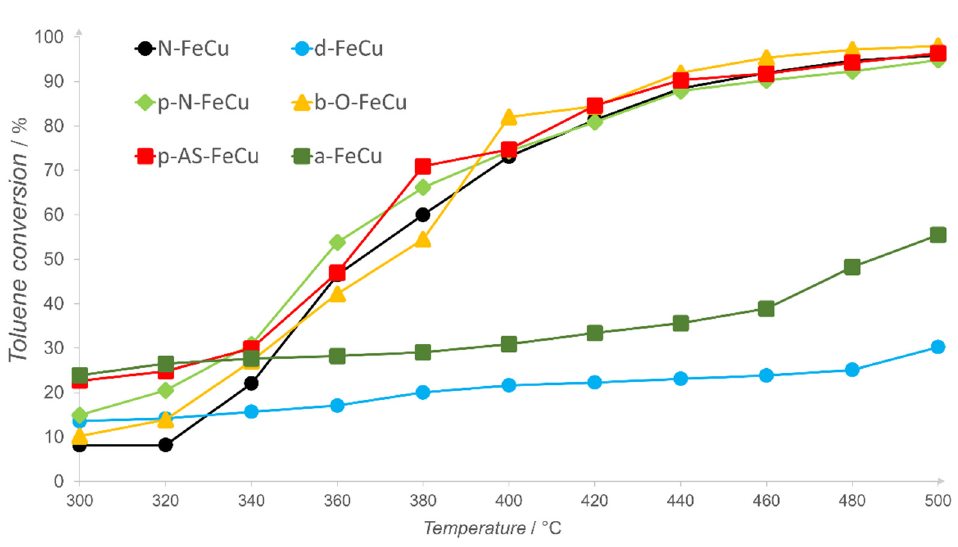
Figure 14. Catalytic performance of Cu- and Fe-containing phases on different alumina supports. WHSV = 1.2 h − 1 . Catalyst “p-AS-FeCu” was chosen for stability and reusability determination (Figure 15). During the time on stream (TOS) the fresh catalyst remained stable, where the conversion of toluene was between 42% and 50%. After first use, the activity dropped and the toluene conversion was 37% at the start and 32% at the end of the test. The second use of the catalyst indicated a slight decrease in activity (34–30%) but in the similar conversion range as in the previous stage. This could suggest that the changes of the catalyst occur after first cycle and that the catalyst remains almost unchanged after additional cycles of use.